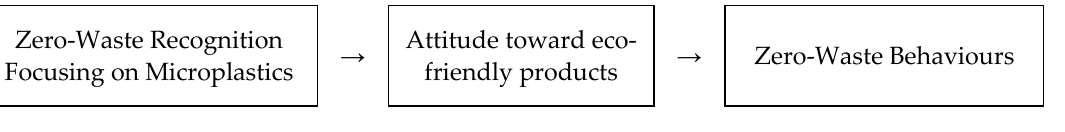
Figure 1. A model of this study.